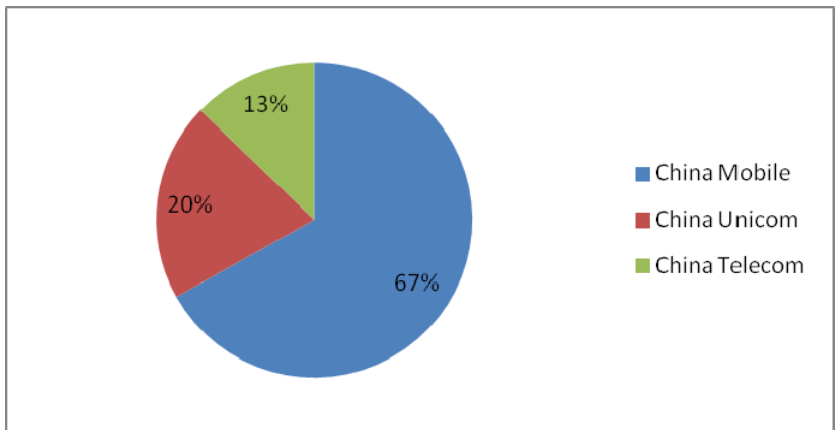
Figure 7. Market share of mobile users of three major telecom operators in